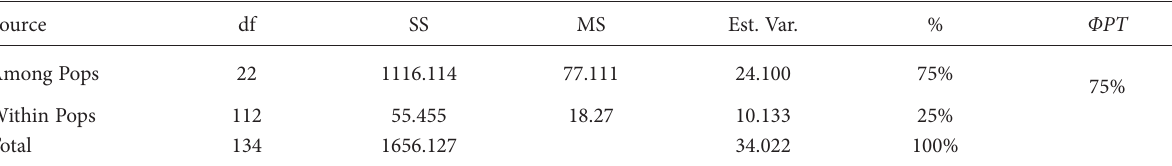
Table 4. Molecular variance analysis.